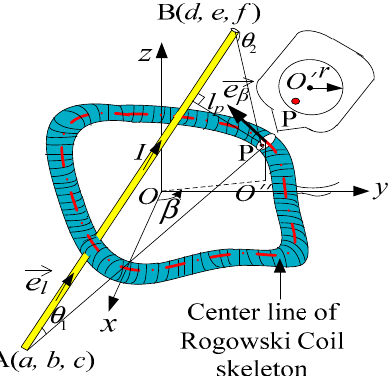
Figure 2. Structure diagram of a Rogowski coil of arbitrary shape and a finite-length straight conductor.